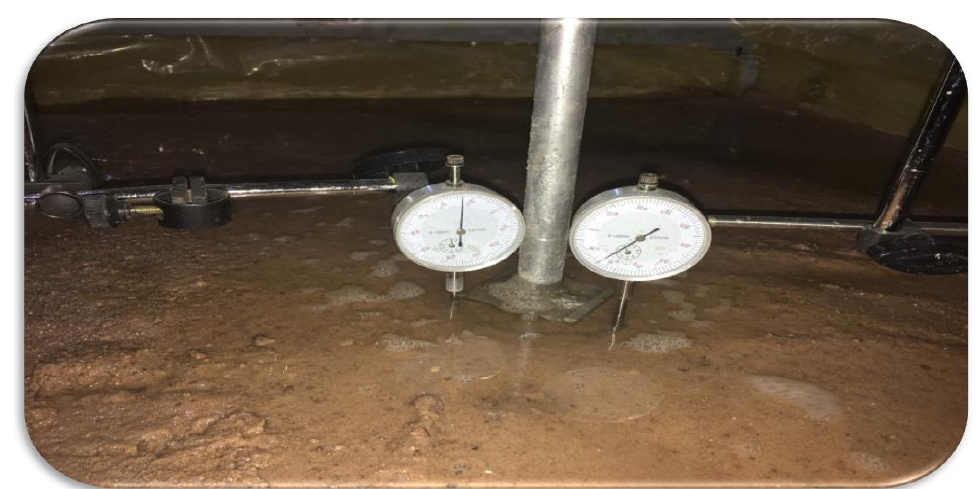
Fig. 5. Preparing treated soil with PPF and cement.